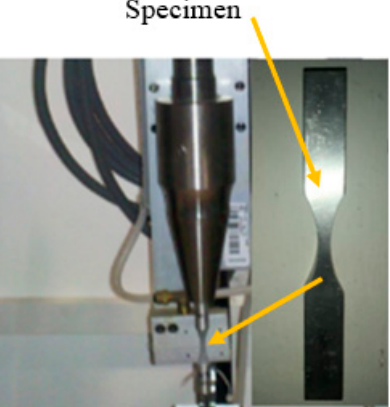
Figure 2. Natural frequency of vibration in longitudinal direction for aluminum alloy specimen AA7075-T6, obtained by modal analysis.